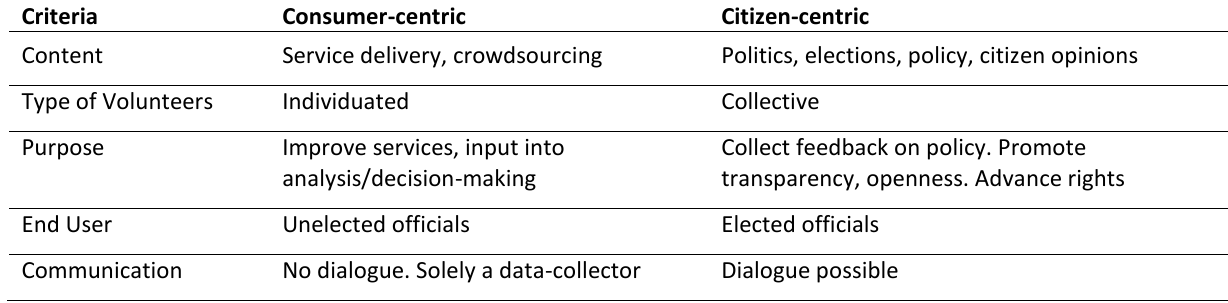
Table 1. Volunteers operationalised in apps.